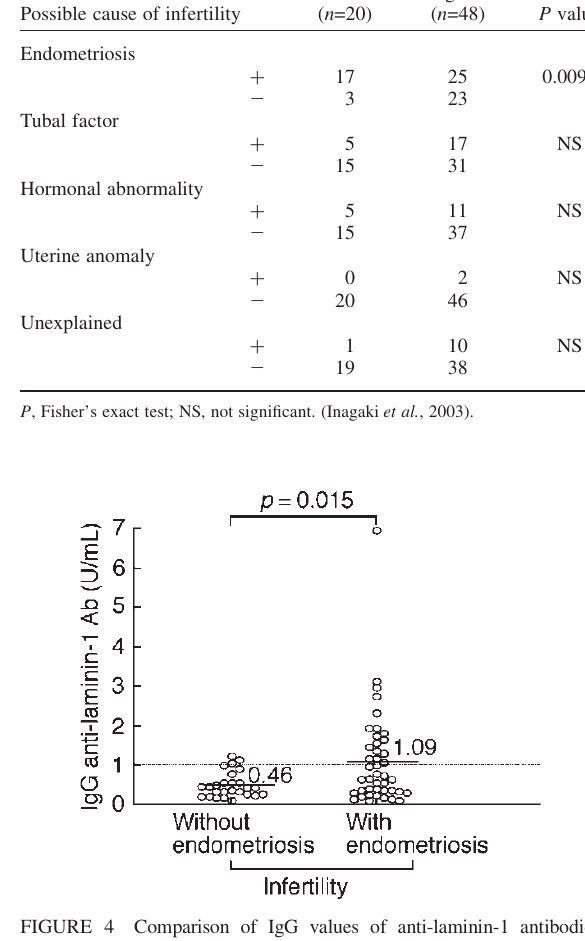
Anti-laminin-1 Abs (IgG)